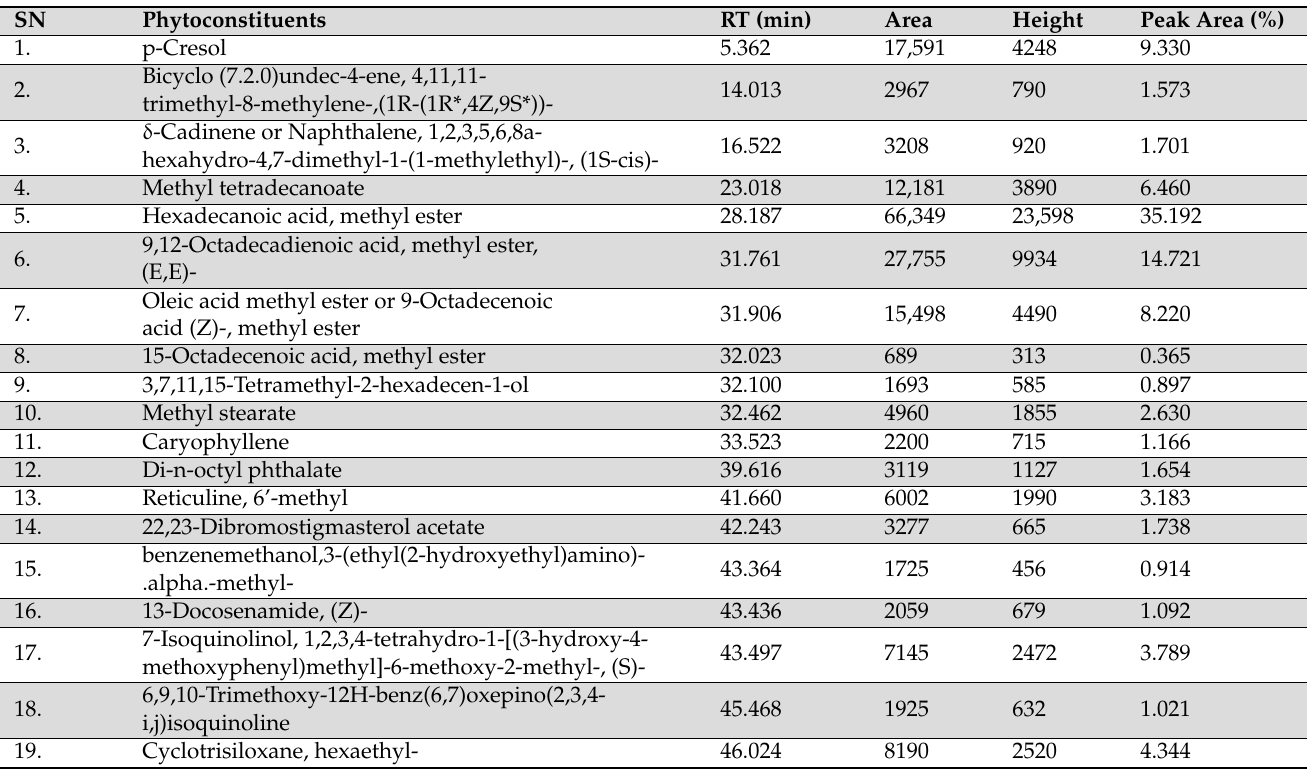
Table 2. Phytoconstituents detected by GC–MS analysis of